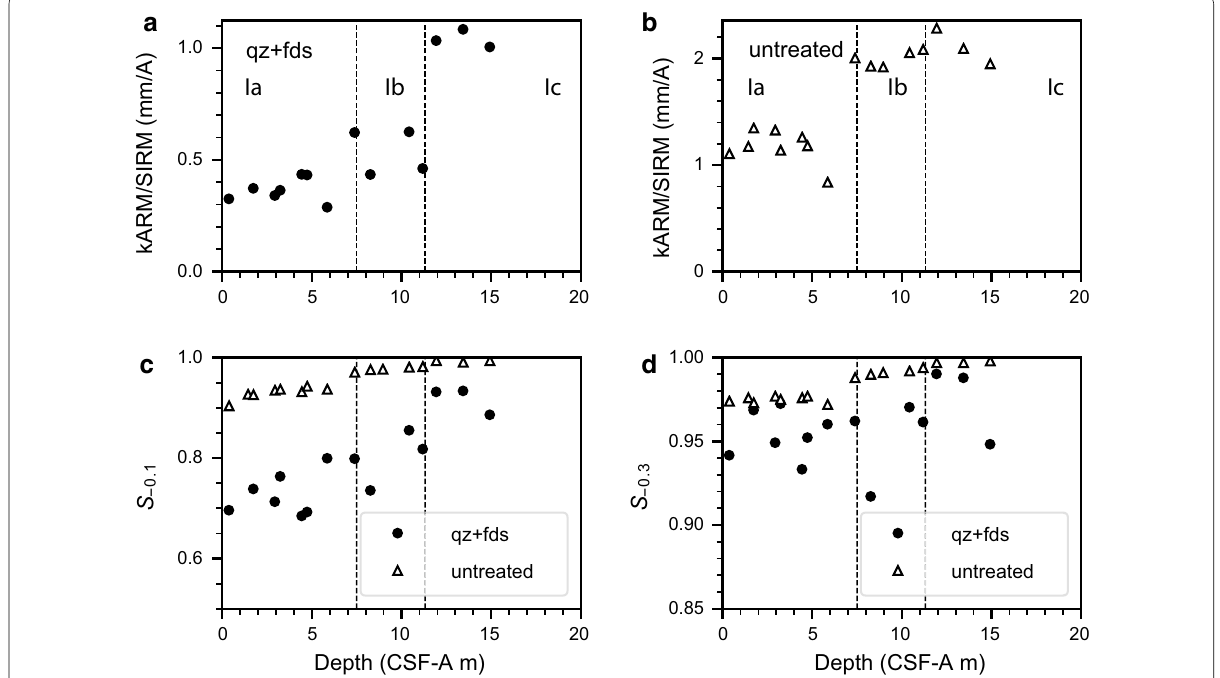
Fig. 6 Depth variation of magnetic properties. Vertical dashed lines represent lithostratigraphic unit boundaries. a , b The kARM/SIRM ratios of quartz and feldspars ( a ) and untreated samples ( b ). c The S values of quartz and feldspars (solid circles) and untreated samples (open triangles). d − 0.1 The S values of quartz and feldspars (solid circles) and untreated samples (open − 0.3